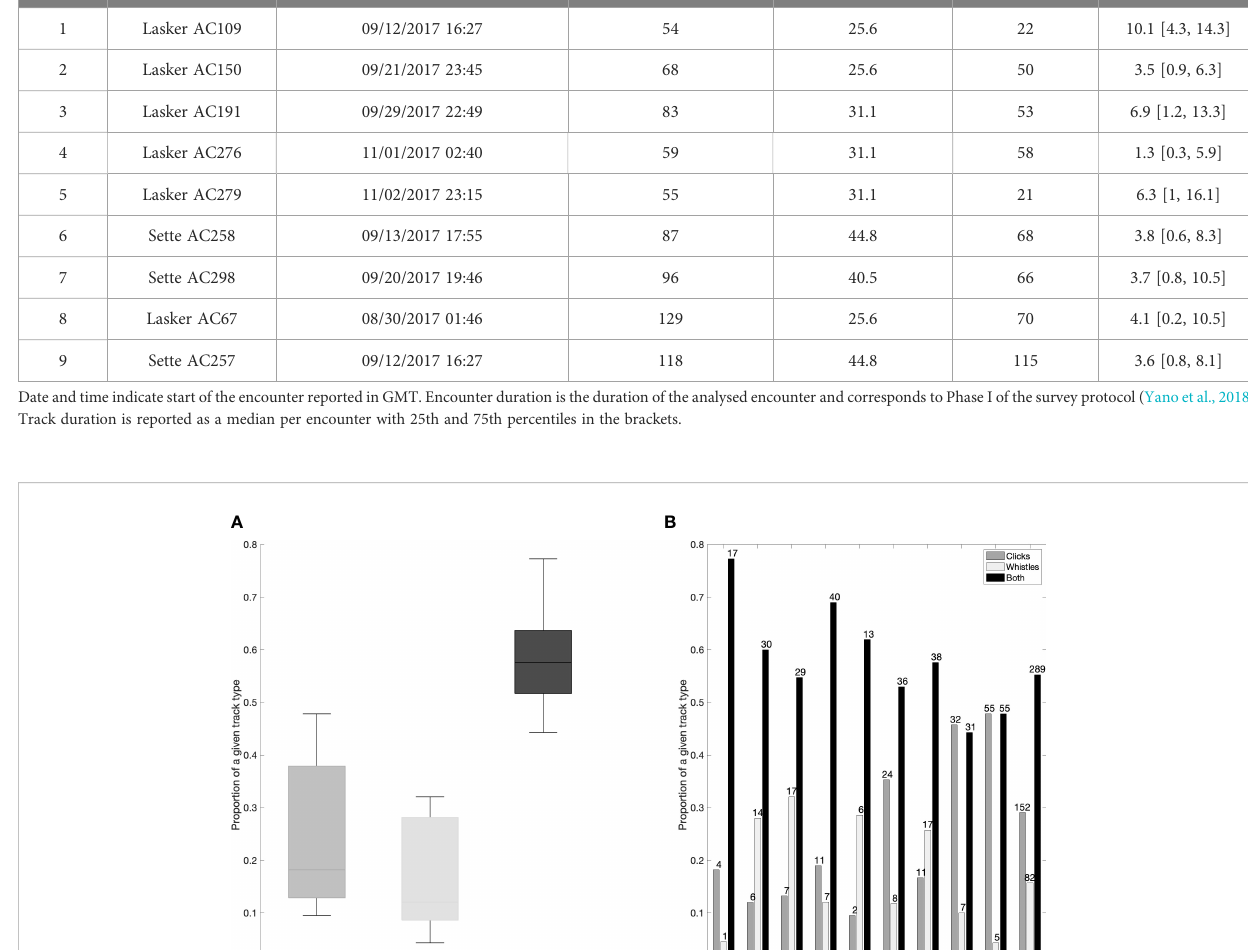
TABLE 1 Acoustic encounters with false killer whales and identi fi ed acoustic subgroup tracks.